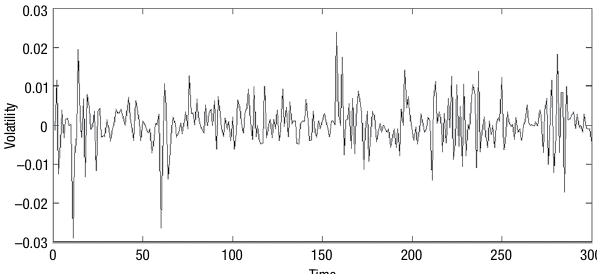
Fig. 24. Clustering on path 3 (volatility data